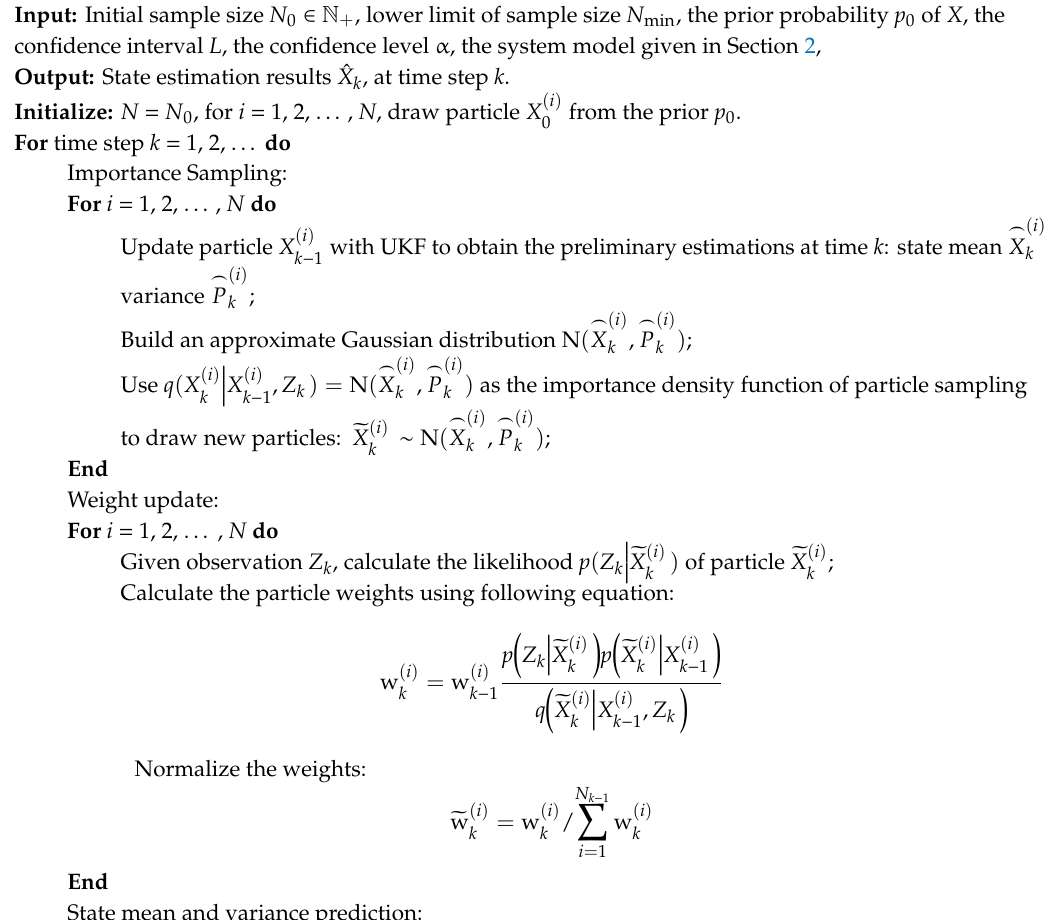
Algorithm A1. Adaptive Sample-Size